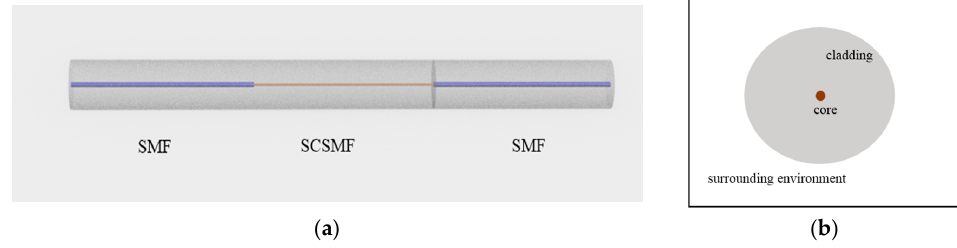
Figure 10. ( a ) Schematic diagram and ( b ) cross-section of the SCSMF structure.